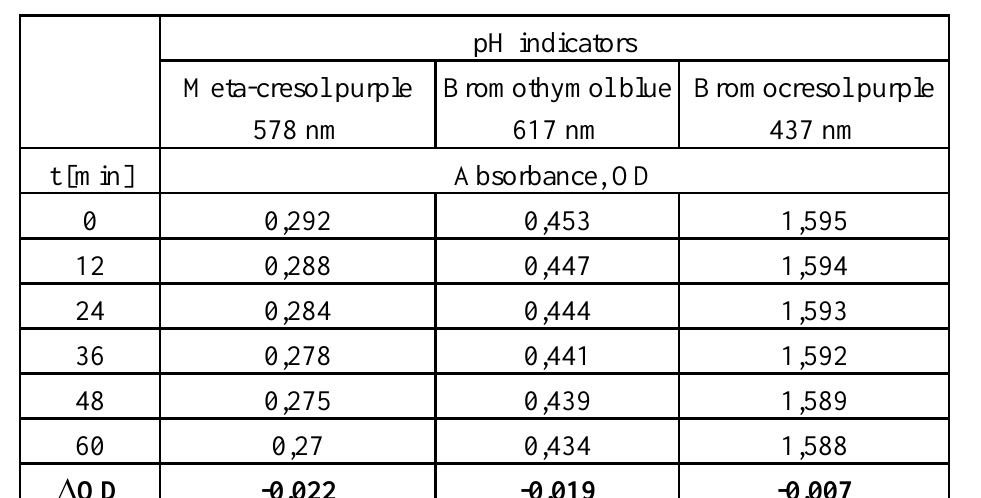
Table 1. Changes of absorbance in time for samples with different pH indicators measured at a specific